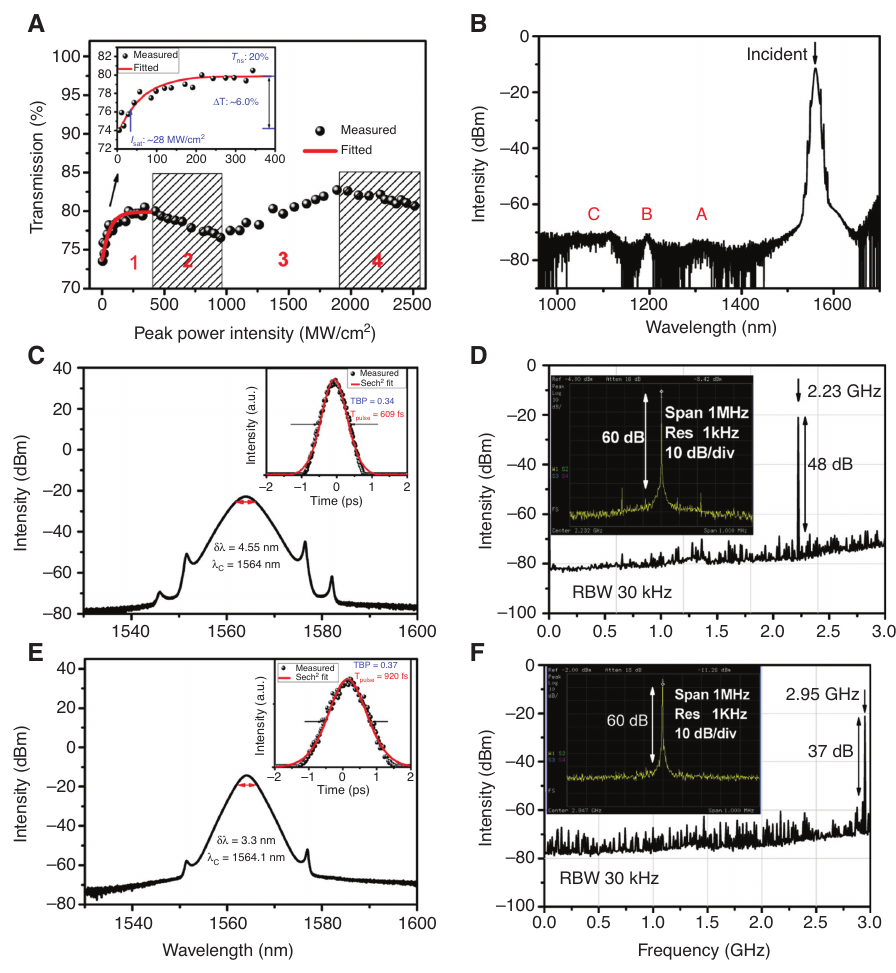
Figure 8: HML operation obtained in a fiber laser with a TI-decorated microfiber SA. (A) Nonlinear saturable transmission curve of a microfiber-based TI film SA. (B) Transmission spectrum measured at ~ 350 W of incident peak power. (C) and (D) Spectrum and autocorrelation trace for the case of 2.23 GHz. (E) and (F) Spectrum and autocorrelation trace for the case of 2.95 GHz. Reproduced with permission [179]. Copyright 2015, The Optical